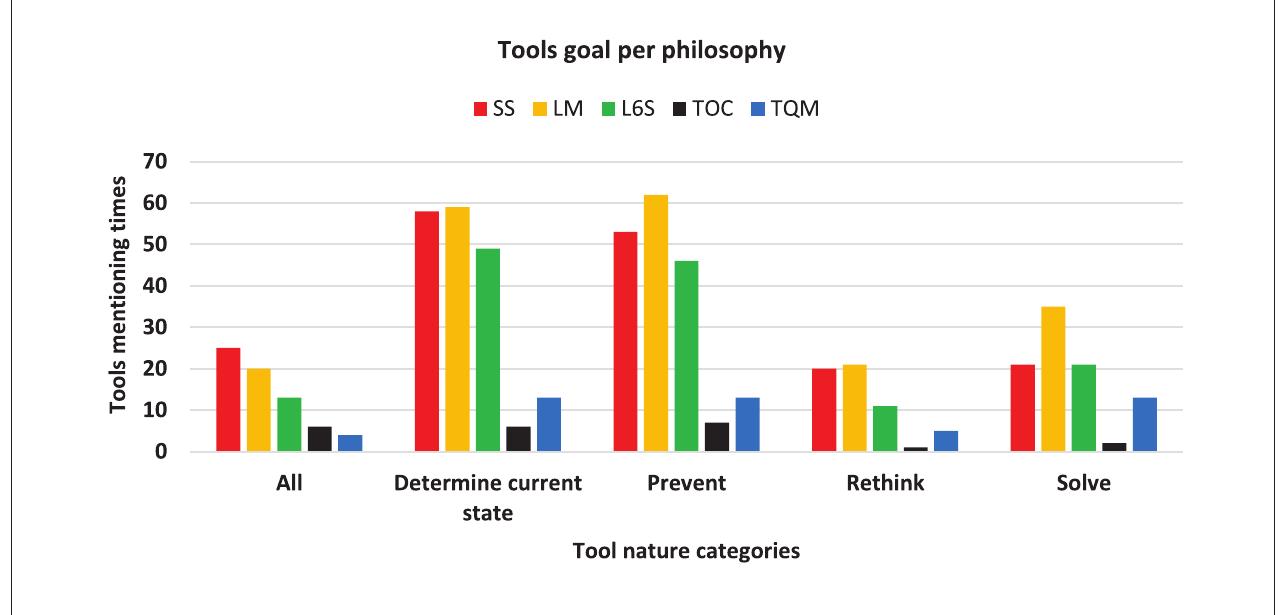
FIGURE 4 | Distribution of the mentions for the goal of the tools for each philosophy.